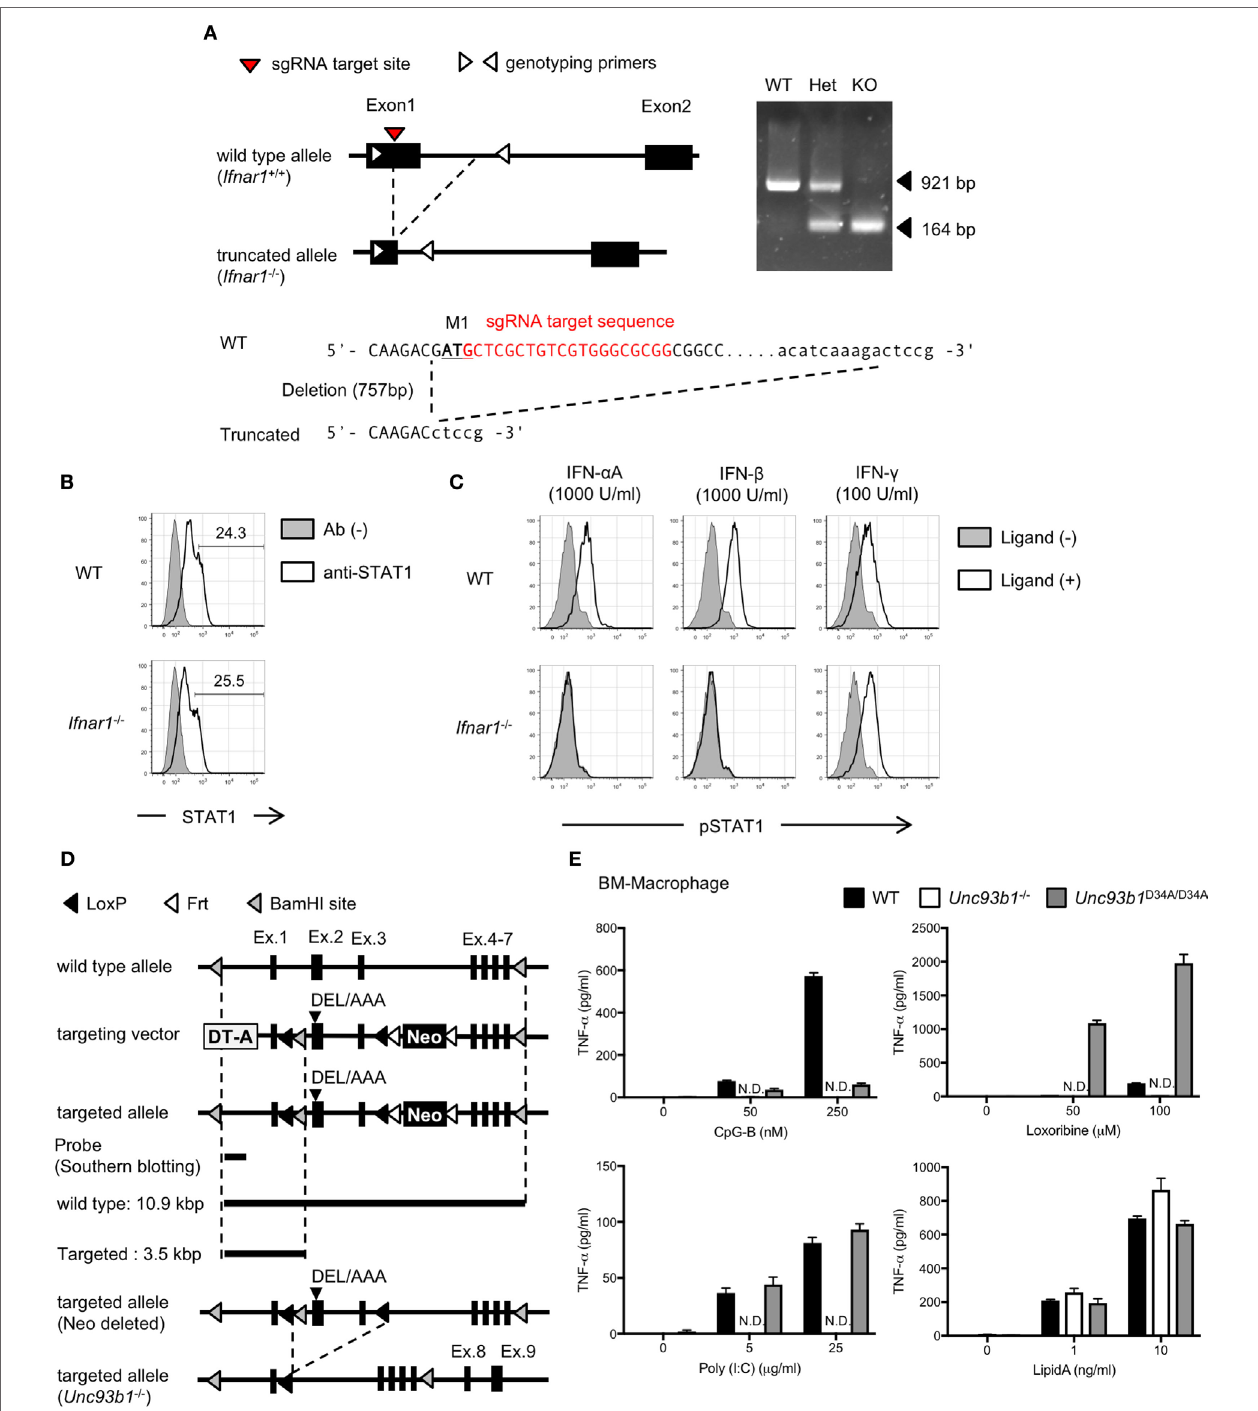
FigUre 1 | Generation of interferon alpha receptor 1 ( Ifnar1 ) − / − or Unc93 homolog B1 ( Unc93b1 ) − / − mice. (a) The strategy to generate Ifnar1 − / − mice and the result of genotyping. The sequences of these oligo DNA shown in the figure were listed in Table 1 . (B,c) Intracellular staining of STAT1 or pSTAT1. Whole splenocytes were stimulated with indicated interferons and phosphorylation of STAT1 was analyzed. The cells highly express STAT1 were gated as shown in (B) and subjected to the analysis of phosphorylation. (D) The strategy to generate Unc93b1 − / − mice. Mice harboring D34A/E35A/L36A mice were generated first. Exon 2 and exon 3 of the DEL/AAA mutant mice were truncated by CAG-Cre to generate Unc93b1 − / − . (e) TNF- α production from bone marrow-derived macrophages with toll-like receptor (TLR) ligands. The cells were stimulated with indicated concentration of TLR ligands and secreted TNF- α in culture supernatant was measured by ELISA. Cells were stimulated in triplicated wells and the mean SD was shown. At least each three mice (B,c) or two mice (e) , sex, and age matched were used. Abbreviation: ND, not detected.